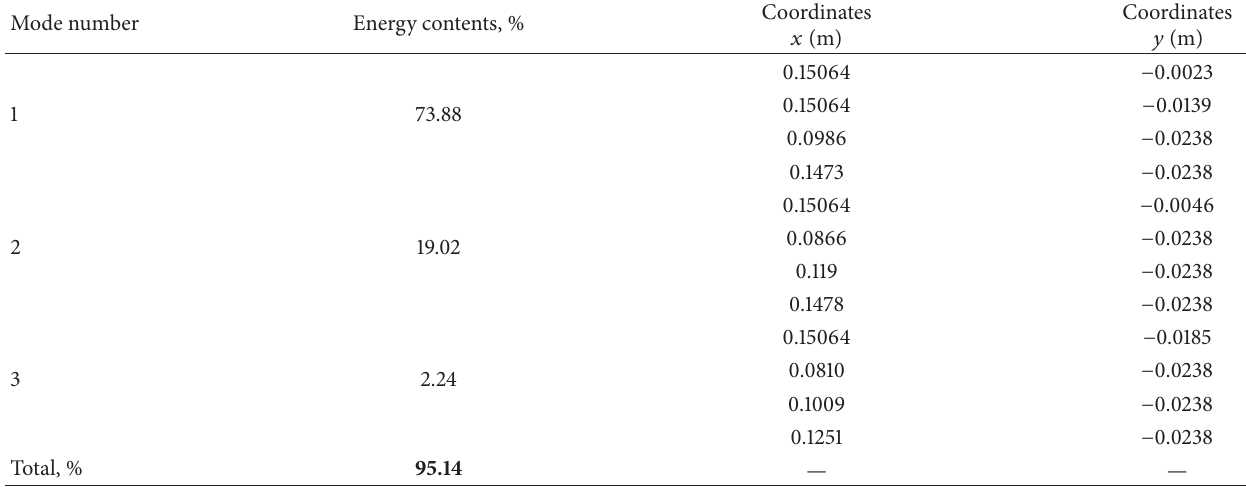
Table 4: Number of modes and energy contents with locations corresponding to minimum and maximum points of modes (with laser). Mode number